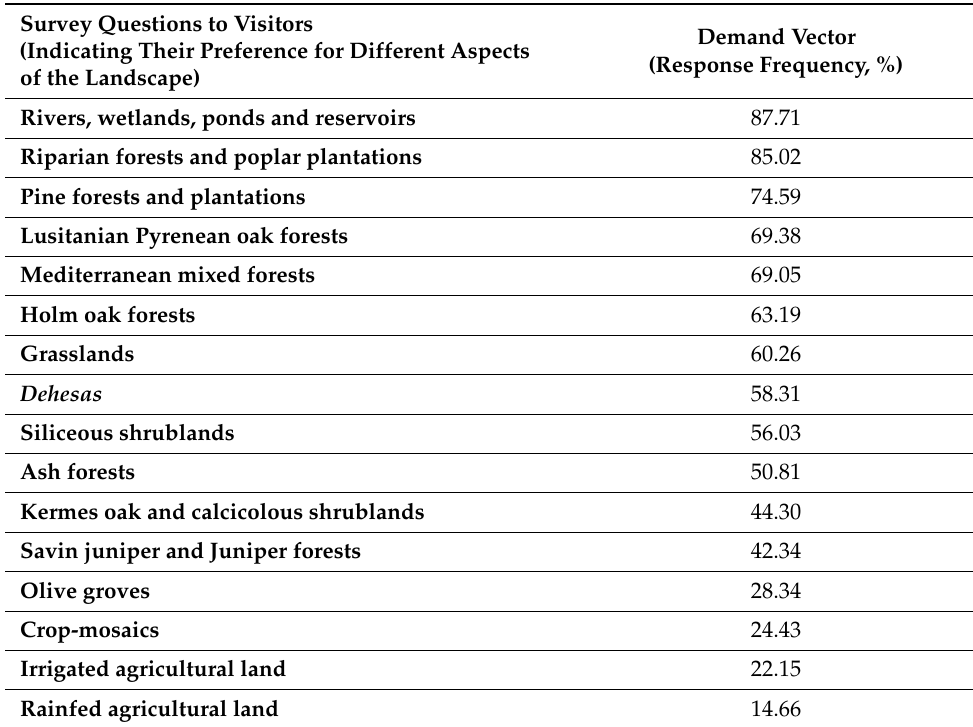
Table 3. Results of the quantification of RES demand by NBT visitors. RES demand vector obtained from the calculation of the frequency of positive responses from visitors to questions in the survey about their preferences for landscape characteristics. The results are ordered from highest to lowest value of frequency of response to the survey